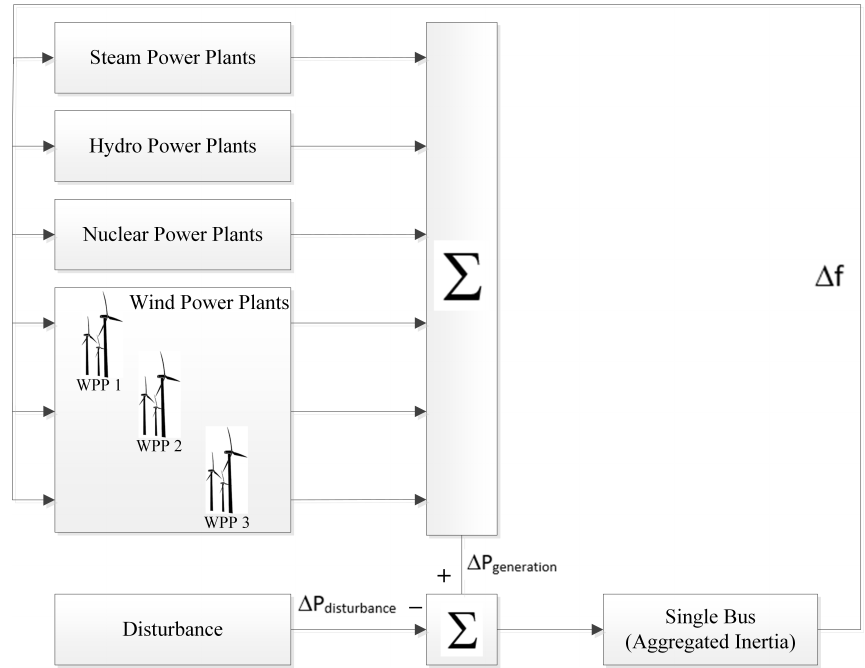
Figure 5. Single bus model of large-scale power system model with three aggregated WPPs and other conventional power